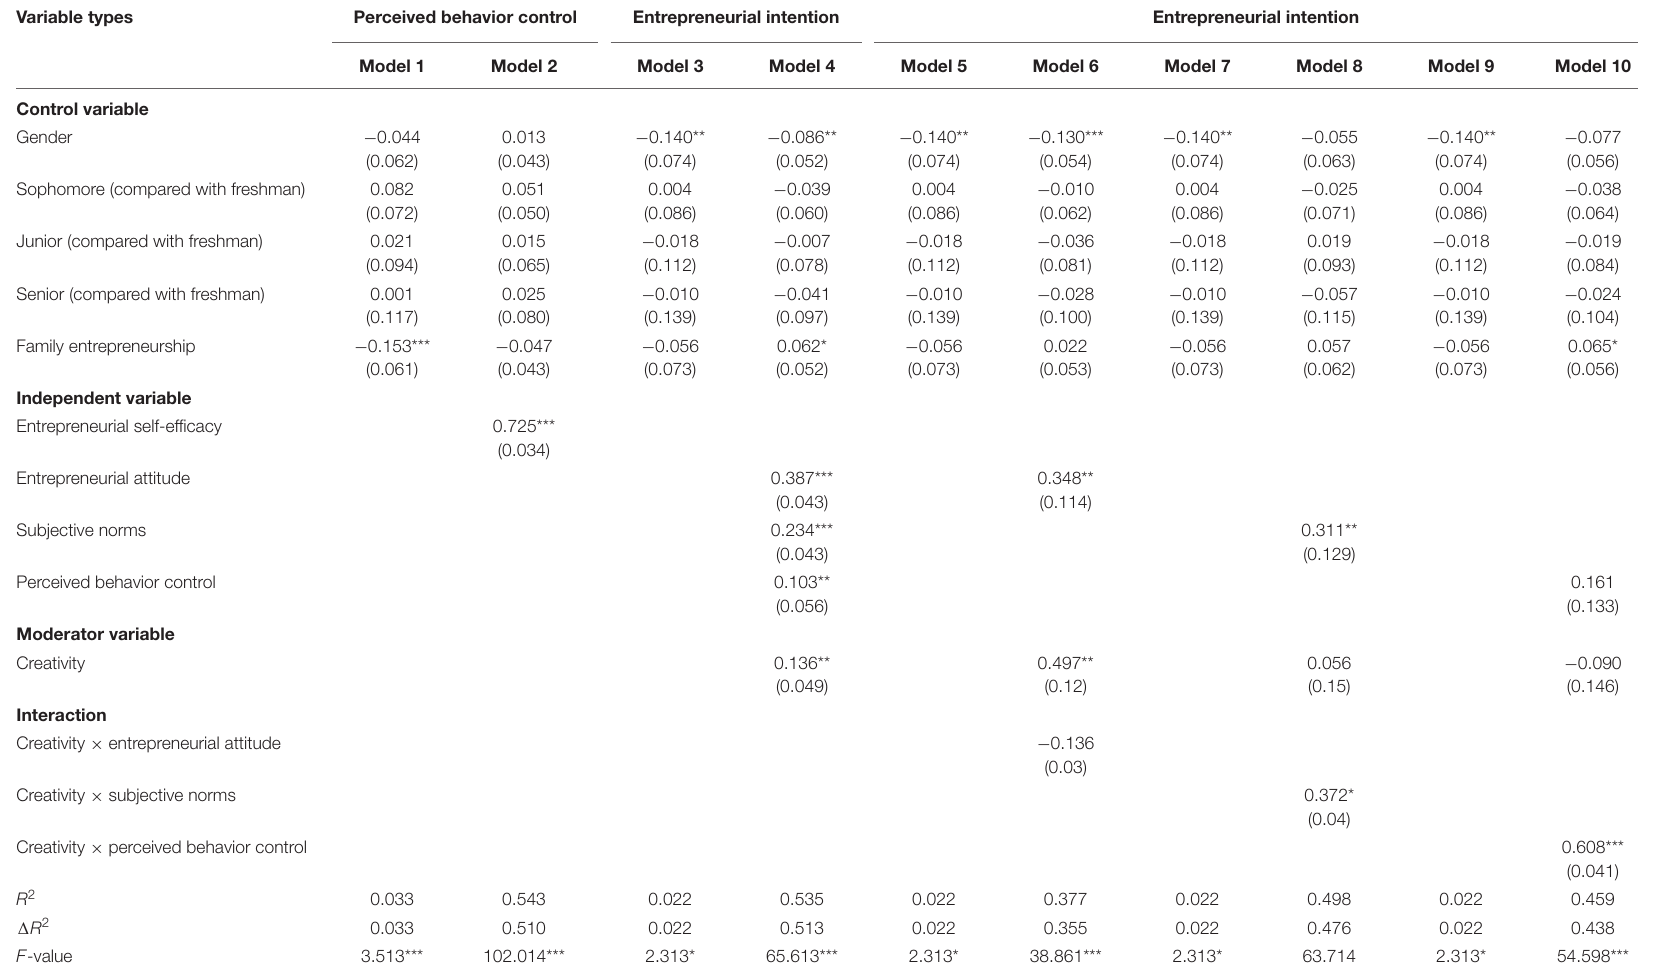
TABLE 6 | Results of regression